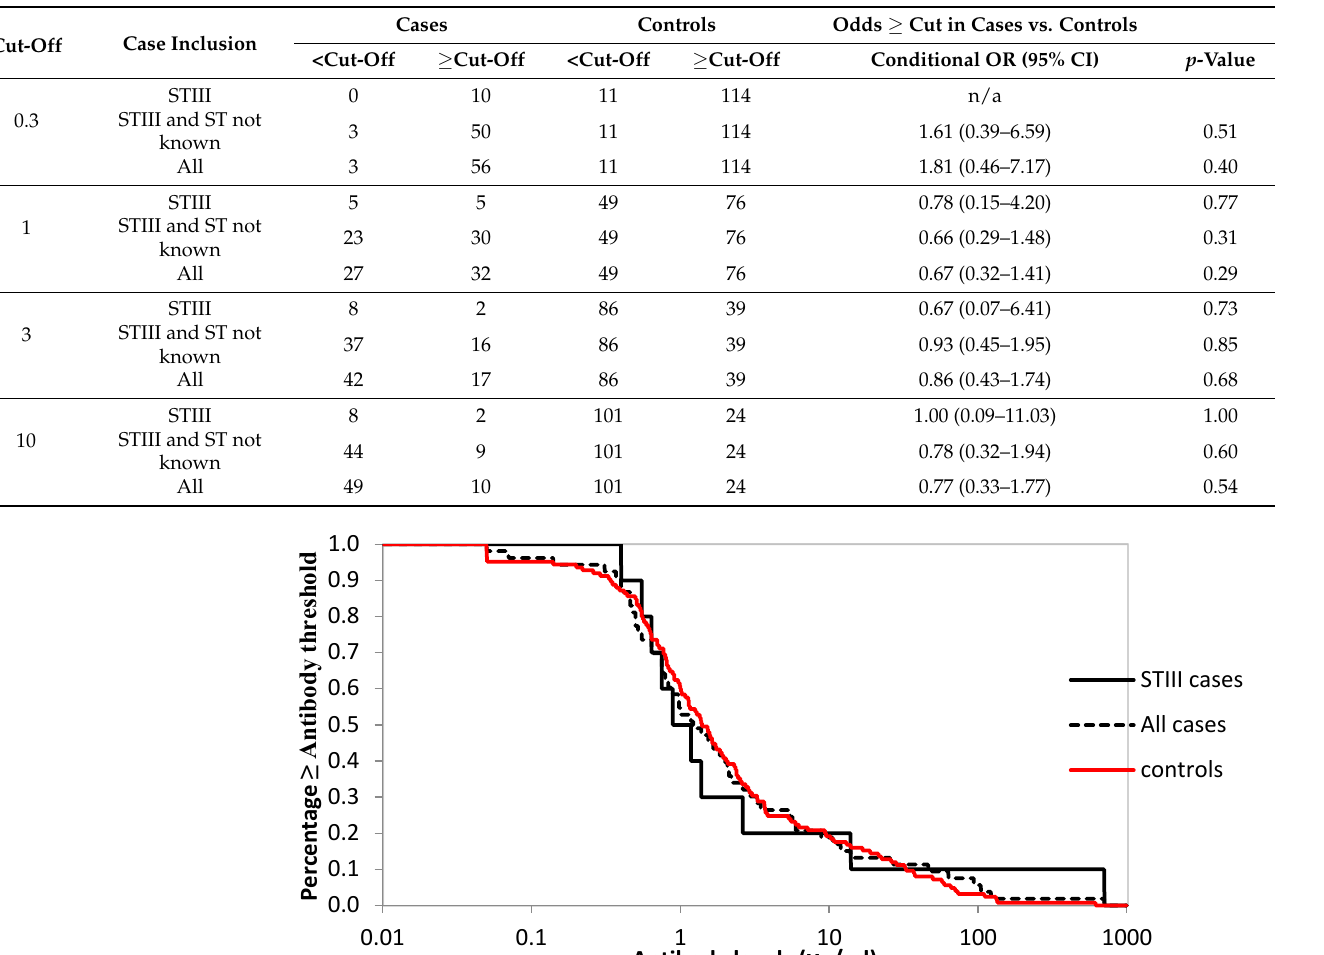
Table 3. Conditional logistic regression results using serotype (ST) III titres with cut-offs at 0.3, 1, 3, and 10 and different case definitions.